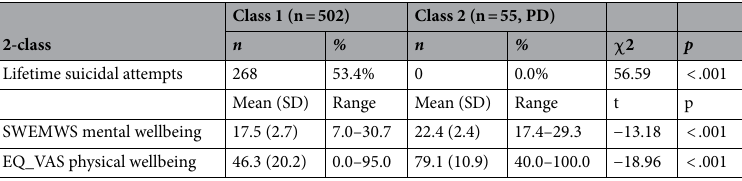
Table 2. Concordance of group membership in suicidal attempts and mental and physical wellbeing (n = 557). SD: Standardised Deviance; PD: Positive Deviant; SWEMSWS: short Warwick–Edinburgh Mental Well-being Scale; EQ-VAS: EuroQol visual analogue scale